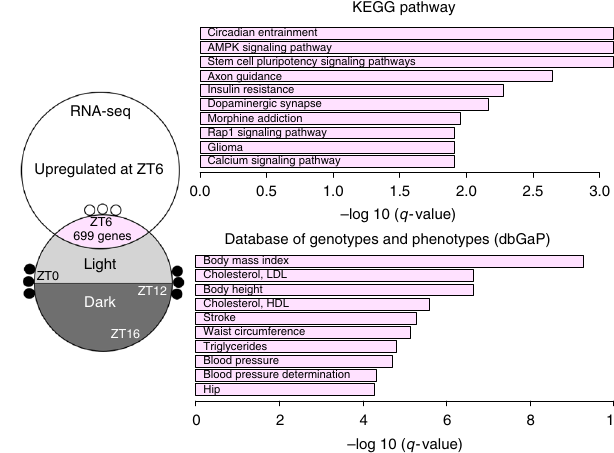
Fig. 5 Genes with dysregulated DNA methylation and expression at ZT6 are enriched for human PWS-relevant phenotypes and pathways. Filled circles represent methylated and empty circles represent unmethylated CpGs. Top ten terms graphed in bar plots as – log 10 ( q -value) (Fisher ’ s exact test with Benjamini – Hochberg correction). See Supplementary Data 8